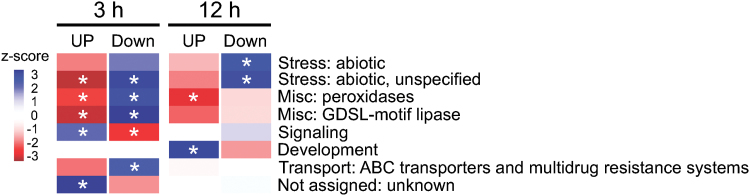
Overrepresented functional categories of genes differentially expressed after LCO treatment. Based on the analysis (see Supplementary Fig. S5 for details), functional categories were identified that showed statistically significant representation (z-score > 1.96 or < -1.96): red to brownish-red, under represented functional category; blue to dark-blue, overrepresented functional category.